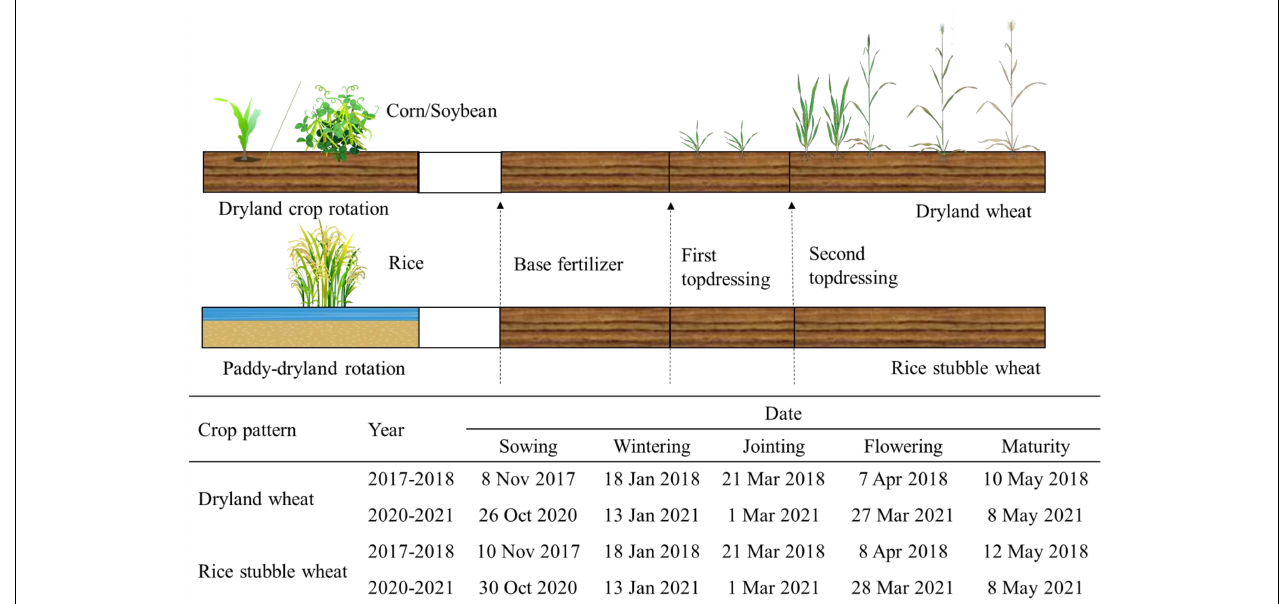
FIGURE 1 | Schematic diagram of crop rotation and timing of nitrogen fertilizer